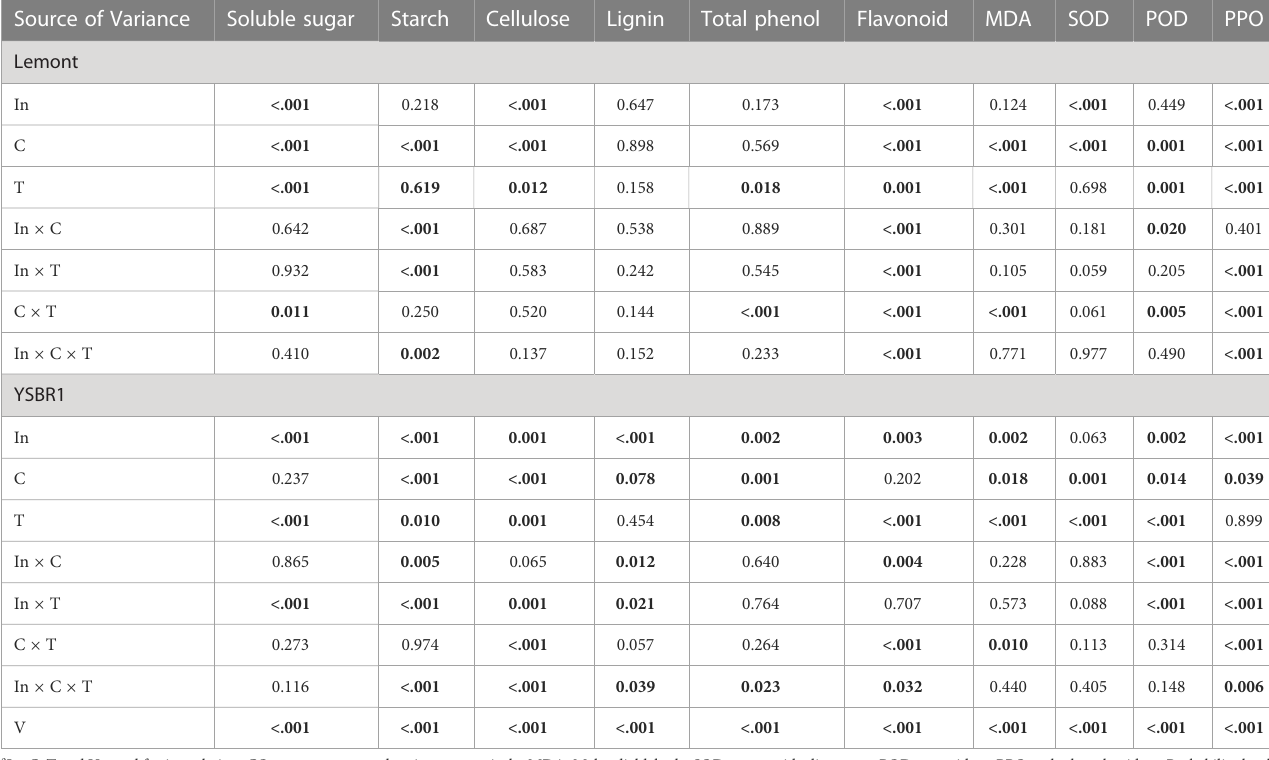
TABLE 4 Summary of analyses of variance (ANOVA) for the in fl uence of inoculation, CO 2 and temperature on physiological parameters in stems of cvs Lemont and YSBR1 in 2021 a . Source of